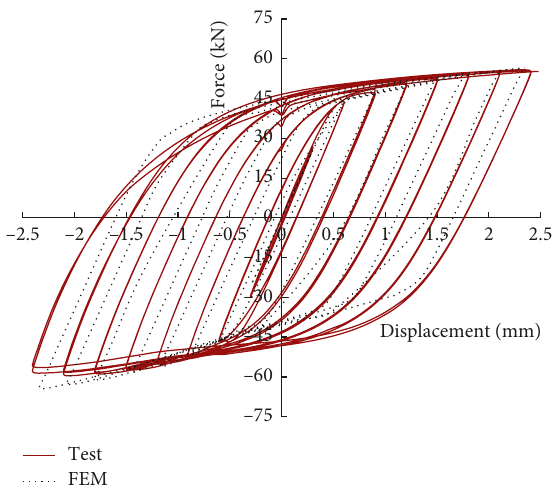
Figure 13: Comparison of hysteresis loops of